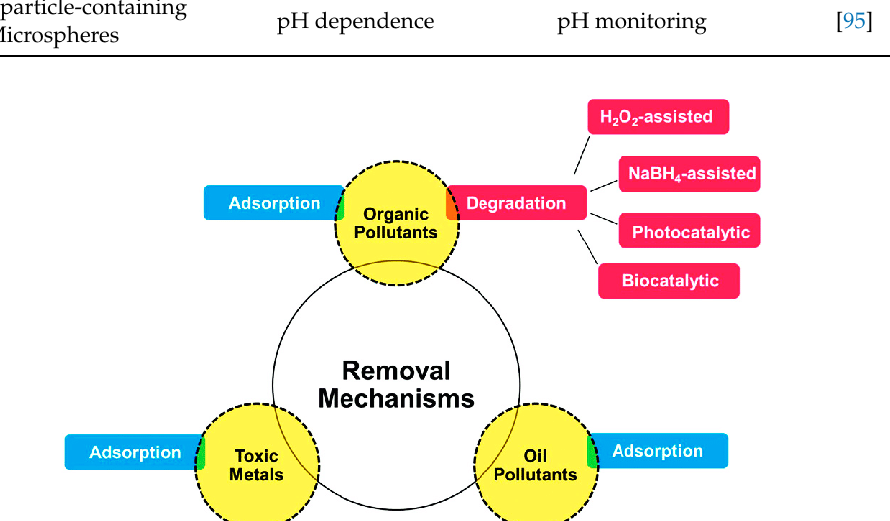
Figure 4. Di ff erent pollutant removal mechanisms used by nano / micromotors (adapted with permission Figure 4. Different pollutant removal mechanisms used by nano/micromotors (adapted with from Royal Chemical Society) permission from Royal Chemical Society) [84].